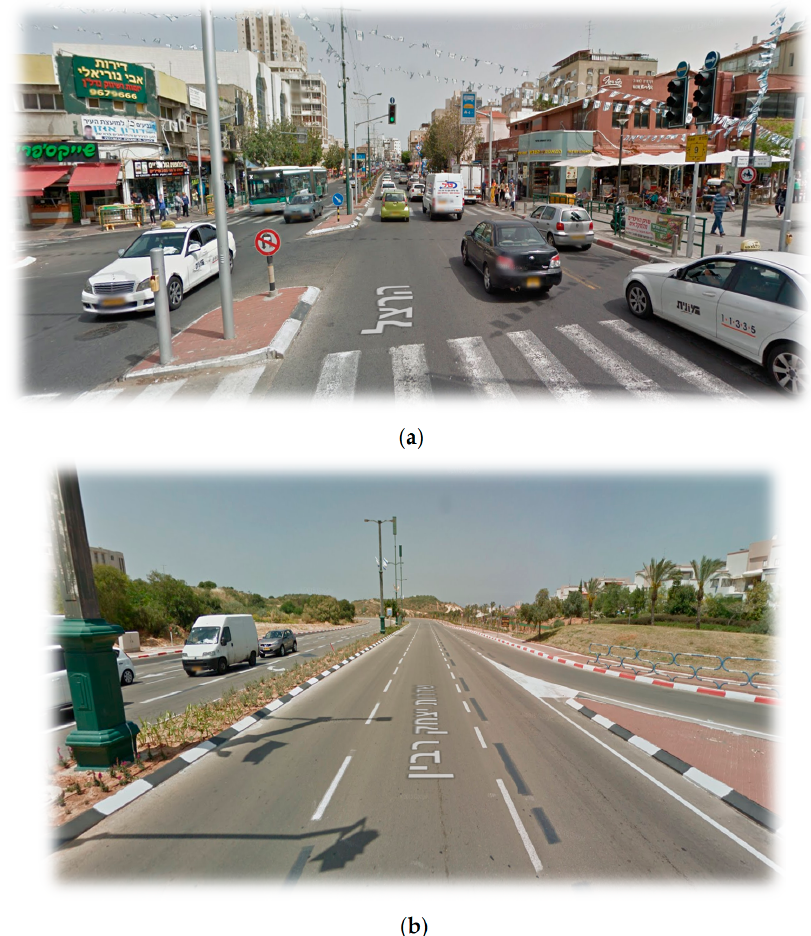
Figure 3. Neighborhood boundaries: ( a ) Inner-city neighborhood boundary with pedestrian-oriented design; ( b ) Suburban neighborhood boundary with automobile-oriented design. (Source: Screen captures of Google Street View panoramic images).